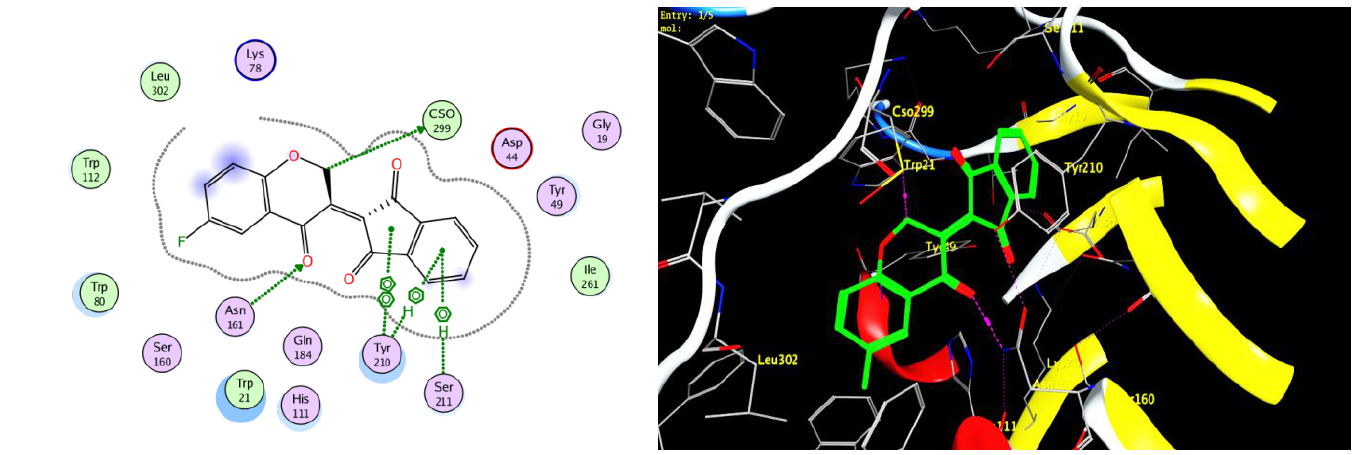
161 and hydrophobic interaction with TYR 219 and SER 211 (Figure 8).